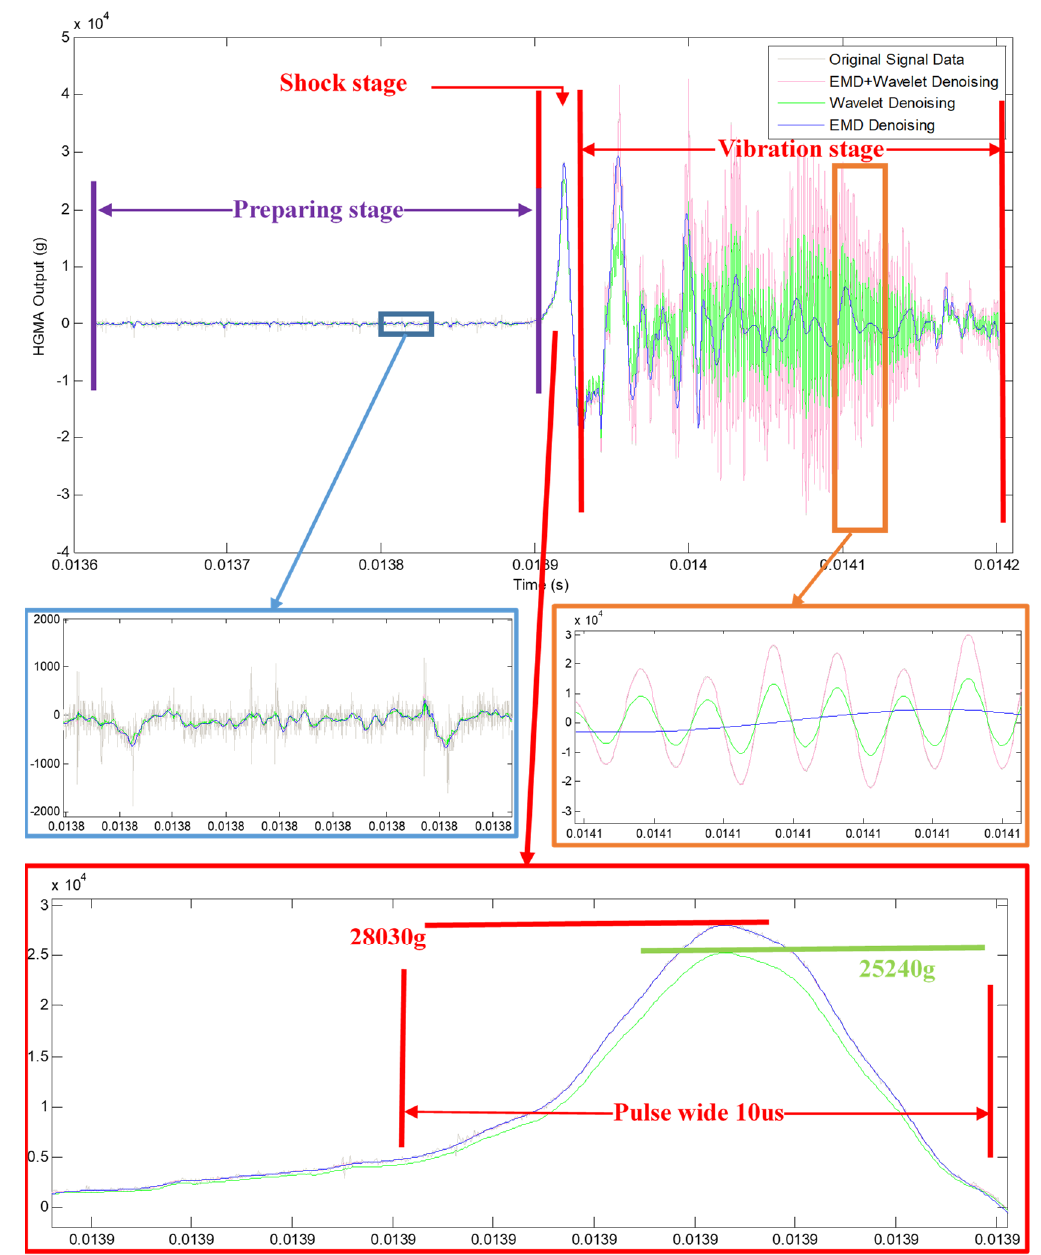
Figure 7. Signals before and after denoising.